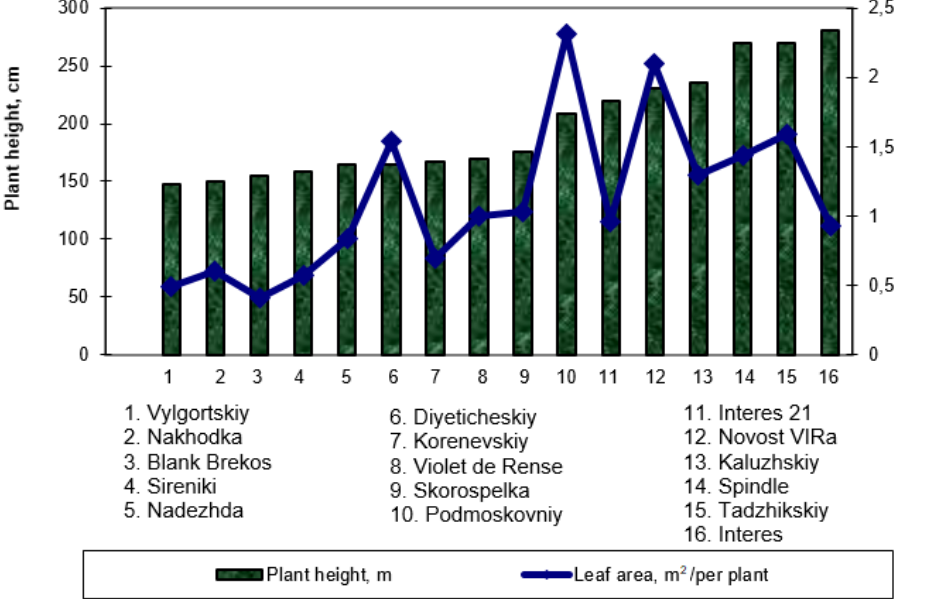
Figure 4. Results of biometric indicator records (on average for 2014–2016). According to the height across all cultivars, the least significant difference (LSD 05 ) was 0.51 m in 2014, 0.36 m in 2015 and 0.46 m in 2016. In terms of assimilation leaf surface values across all cultivars, LSD 05 was 0.63 m 2 /plant in 2014, 0.44 m 2 /plant in 2015 and 0.54 m 2 /plant in 2015, respectively.